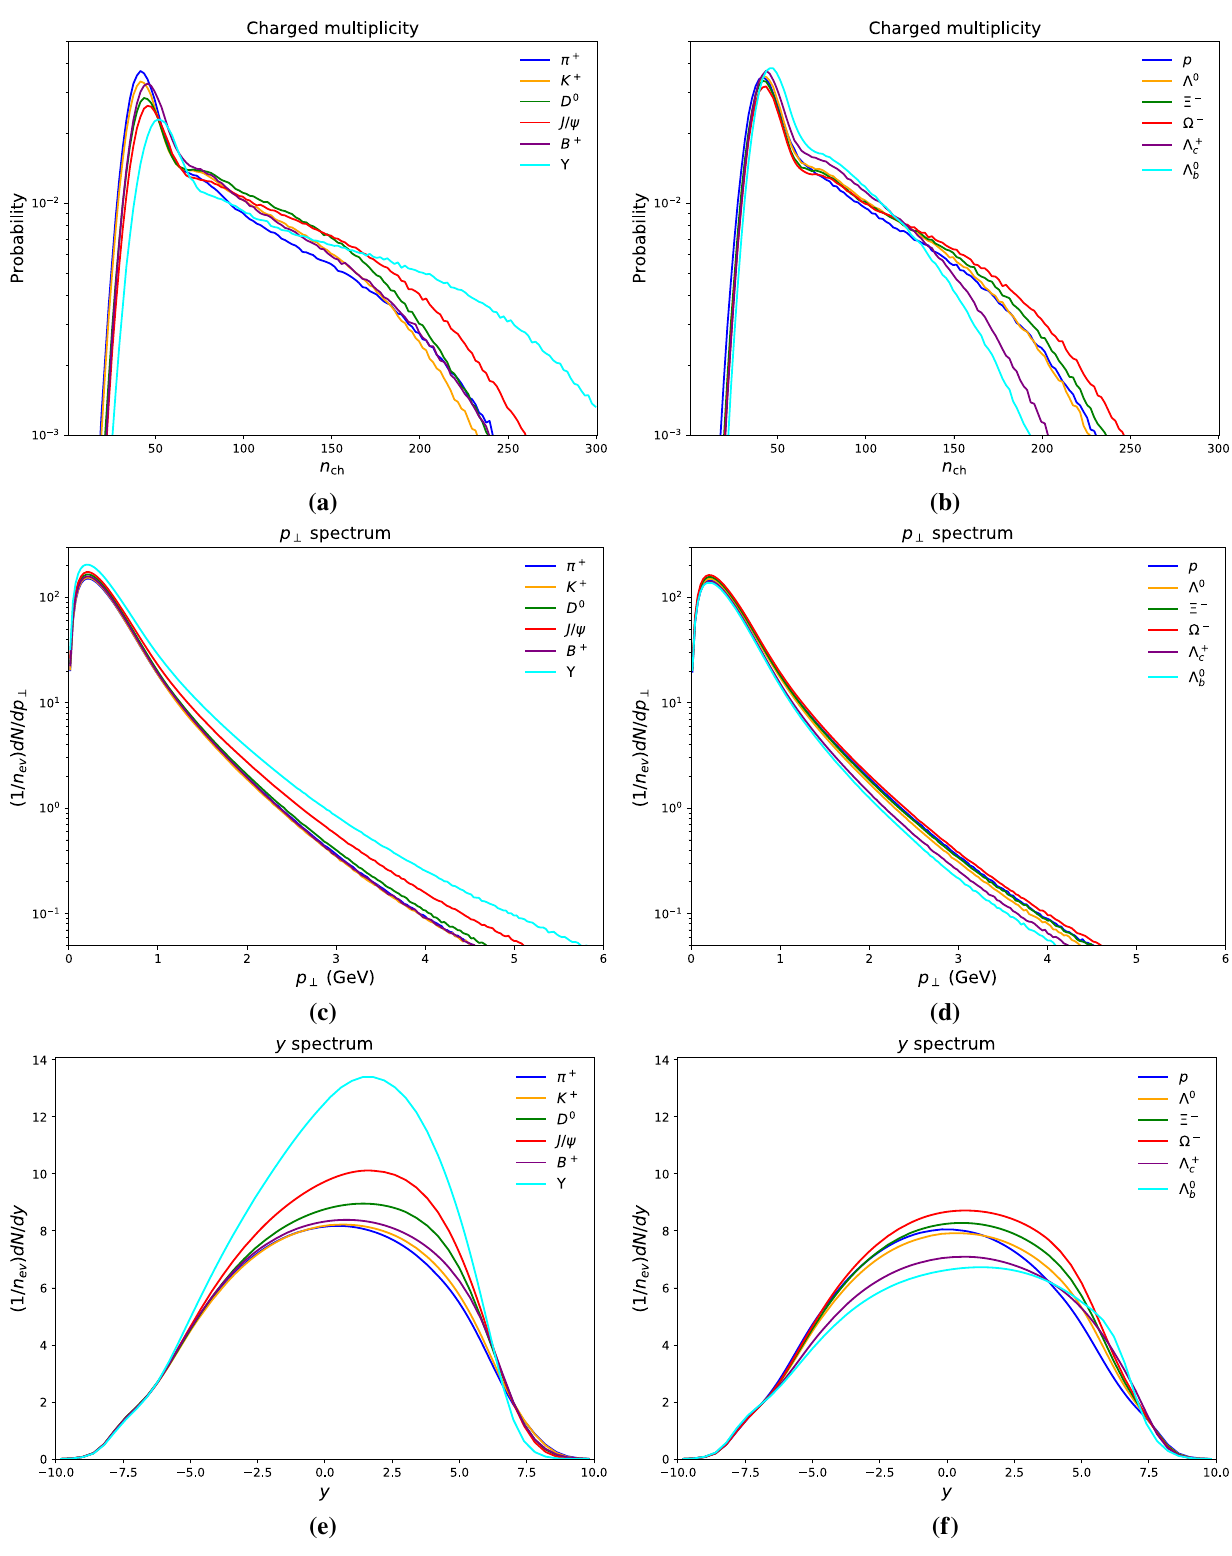
Fig. 7 Charged-hadron a , b multiplicity distributions, c , d p ⊥ spectra and e , f rapidity distributions for a selection of a , c , e meson–proton and b , d , f baryon–proton collisions. All results at a 6 TeV collision energy, and for nondiffractive events only. Labels denote the respective hadron